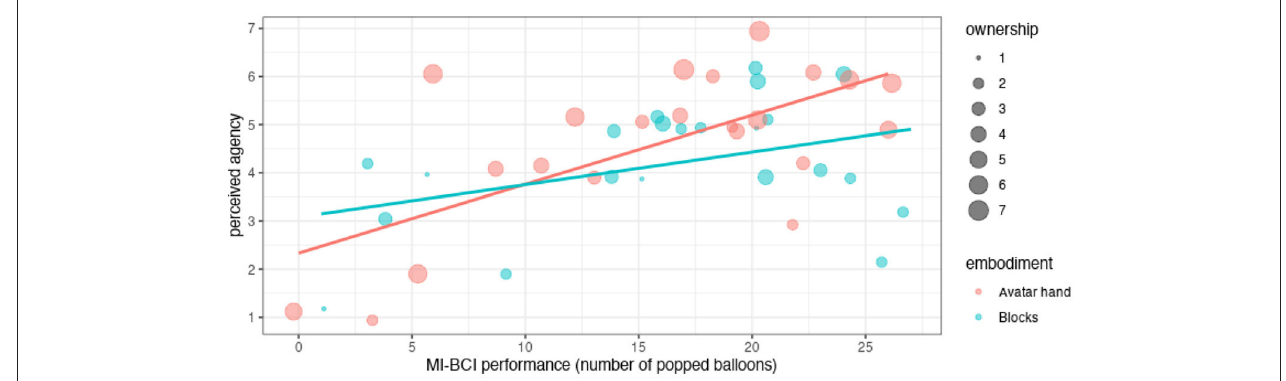
FIGURE 5 | Perceived agency depending on performance and ownership by